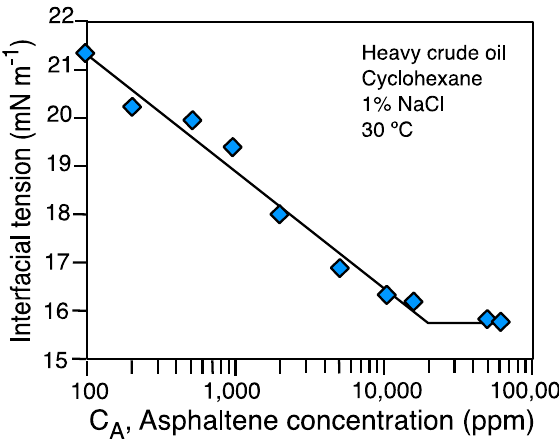
Figure 9. Interfacial tension vs. asphaltene concentration for a brine (1% NaCl)-heavy crude oil diluted in cyclohexane system. Heavy Venezuelan crude oil of 8° API diluted in cyclohexane. T = 30 °C. Measurement made with the oscillating spinning drop equipment.